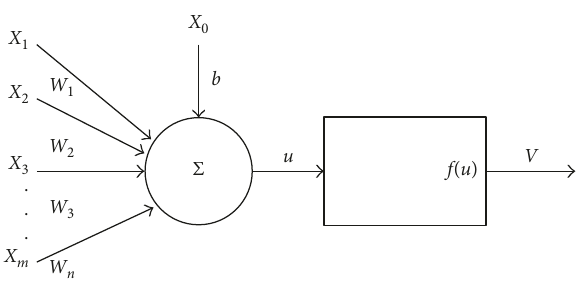
Figure 7: Artificial neuron model. W input X j , and b is a